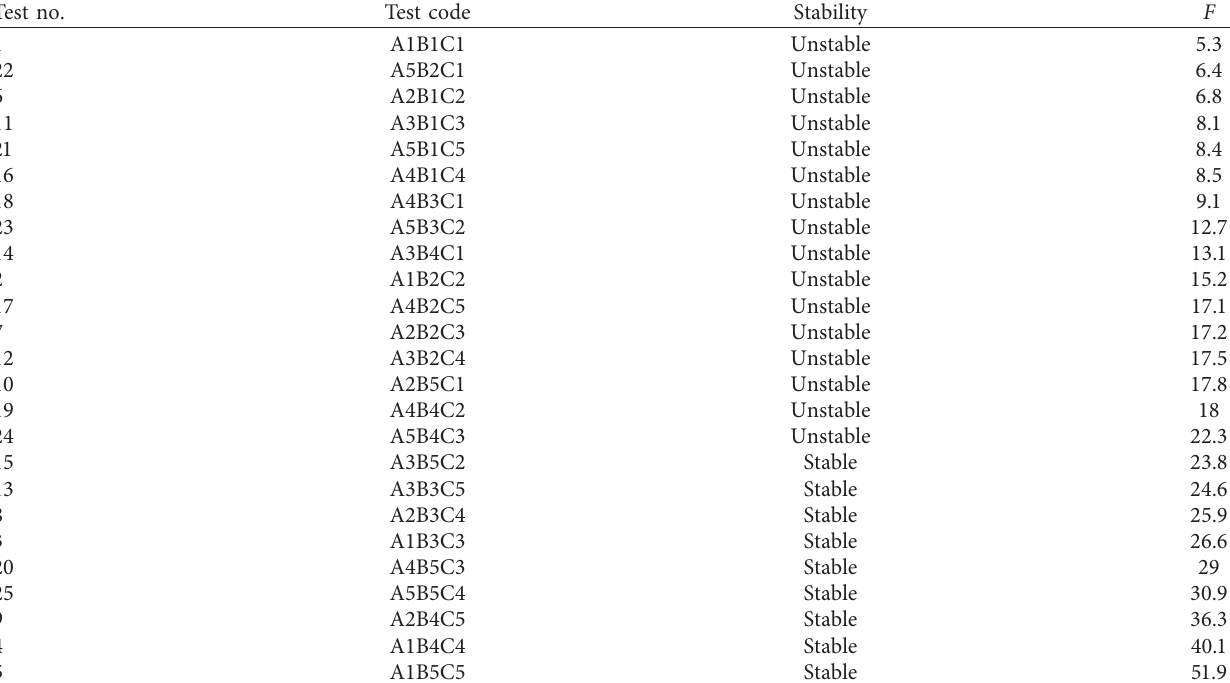
Table 9: Index calculation value of tunnel stability.